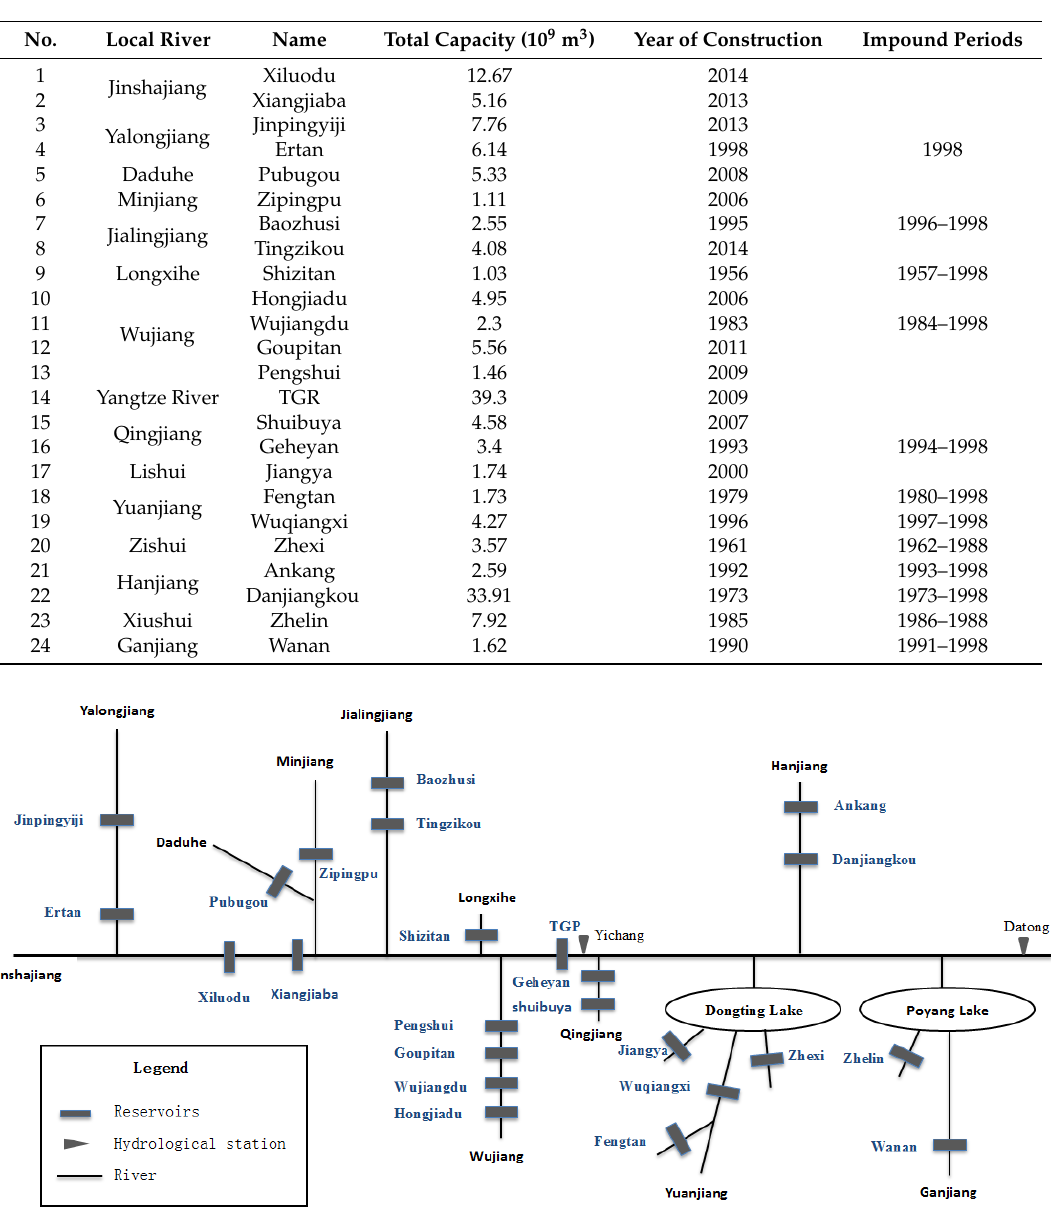
Table 1. Characteristics of main large reservoirs and impound water periods in the Yangtze River.